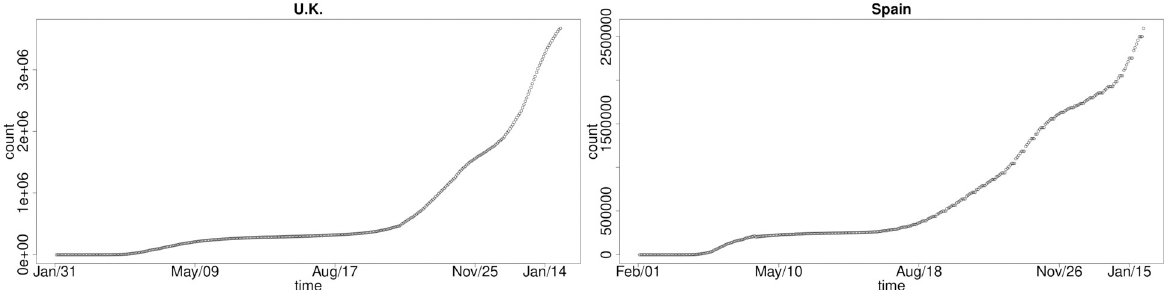
Fig 1. Cumulative COVID-19 national-level infections over time: UK (left) and Spain (right).